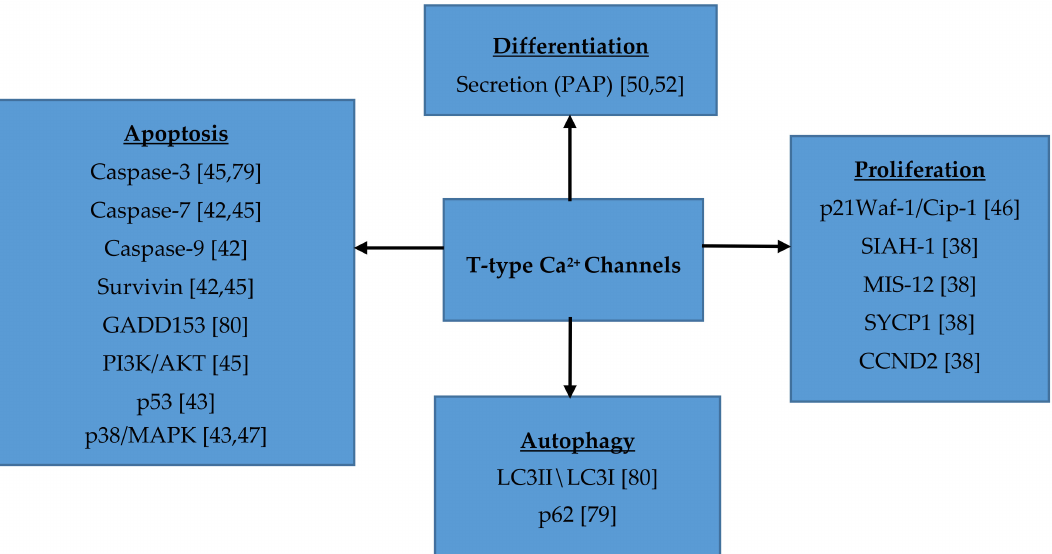
Figure 1. T-type Ca 2+ channels play a significant role in cellular proliferation, differentiation, autophagy and apoptosis through the activation of various signaling